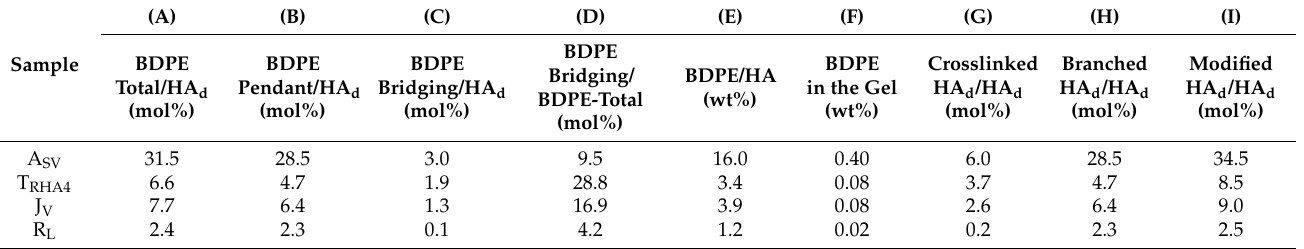
Table 1. Results from the NMR